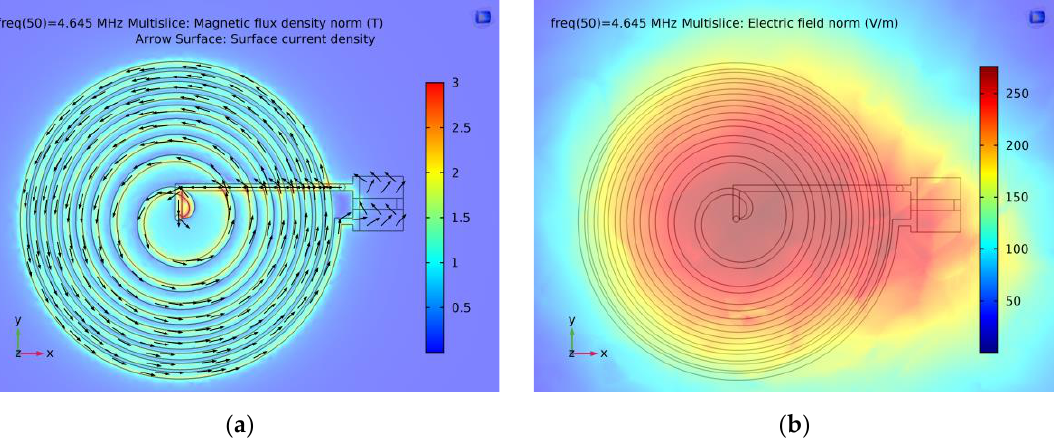
Figure 5. Visualization of the results of simulation of the EM field in the vicinity of the conductive elements of the model of the modified NQR detector antenna at a frequency of 4.645 MHz: ( a ) magnetic field induction, ( b ) electric-field strength.